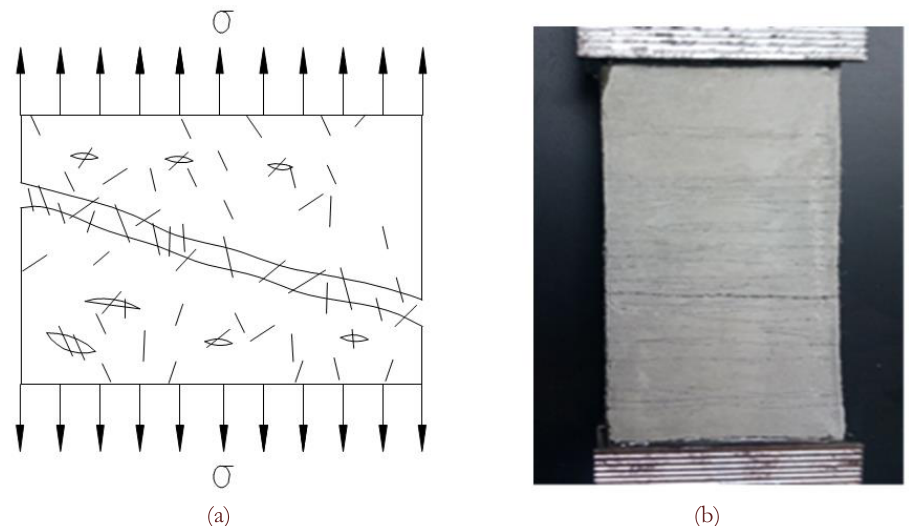
Figure 8: (a) Micro-crack bridging and ductility enhancement effect of PVA fibers; (b) Typical multiple cracks on ECC thin plate specimen under tensile